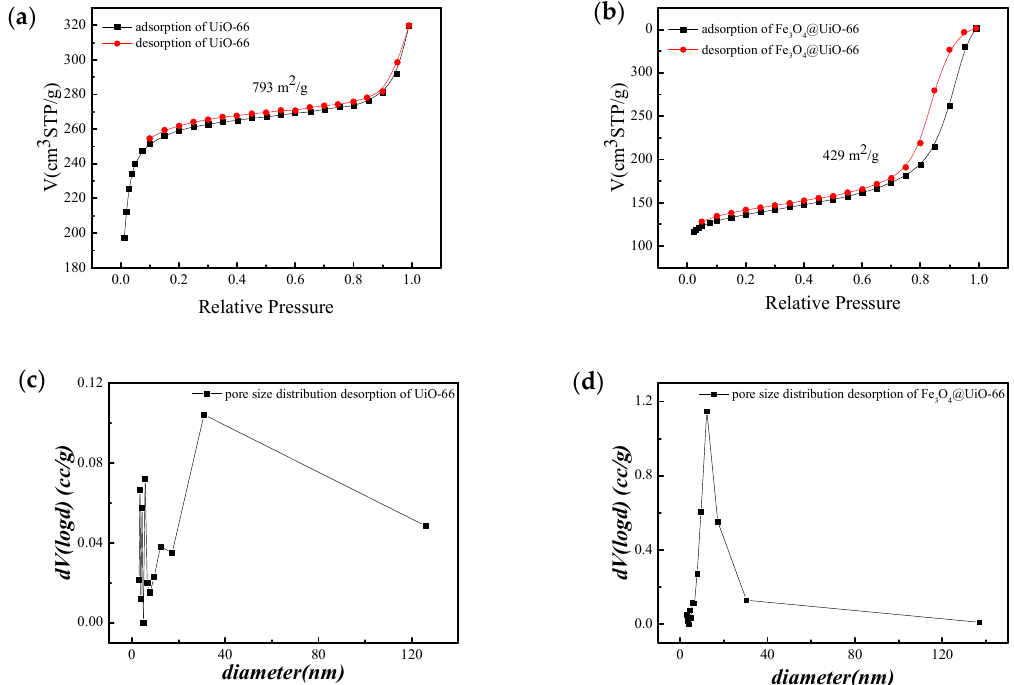
Figure 4. N 2 isothermal adsorption UiO-66 ( a ) and Fe 3 O 4 @UiO-66 ( b ), pore size distribution desorption of UiO-66 ( c ) and Fe 3 O 4 @UiO-66 ( d ).